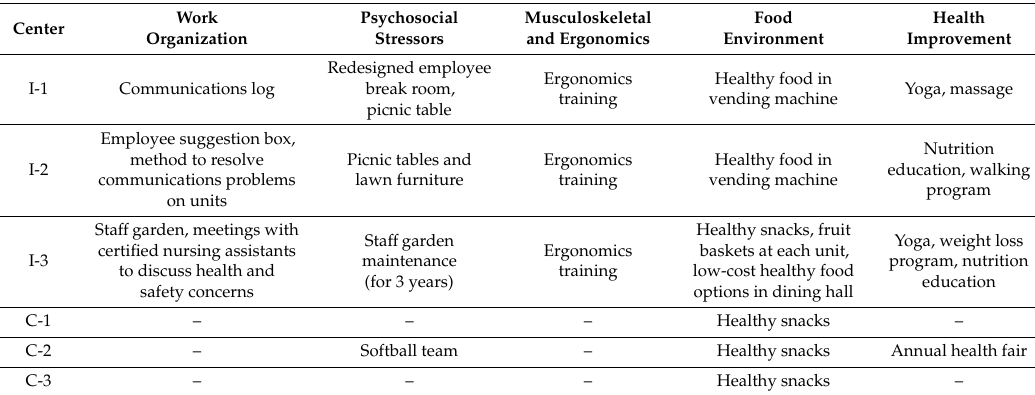
Table 3. Activities carried out by sta ff PIP teams (Intervention centers) and wellness champions (Control centers) during the study period,